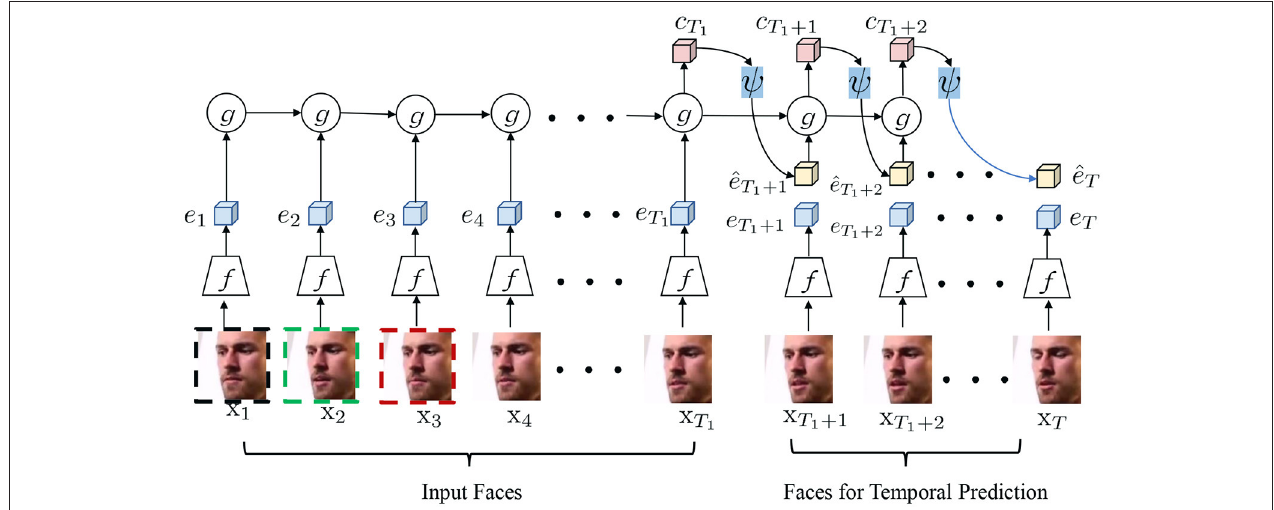
FIGURE 1 | Main idea of the proposed self-supervised temporally predictive coding (TPC) for facial AU representation learning. Given a facial sequence with T faces, we use the preceding T 1 faces as input and exploit the left faces for temporal prediction. Besides, we randomly sampled some triplets in each facial sequence to perceive the temporal consistency and frame-wisely discriminativeness self-supervised. ψ takes the context representation c t as input and estimates the features for the future frame recursively. Better viewed in color and zoom